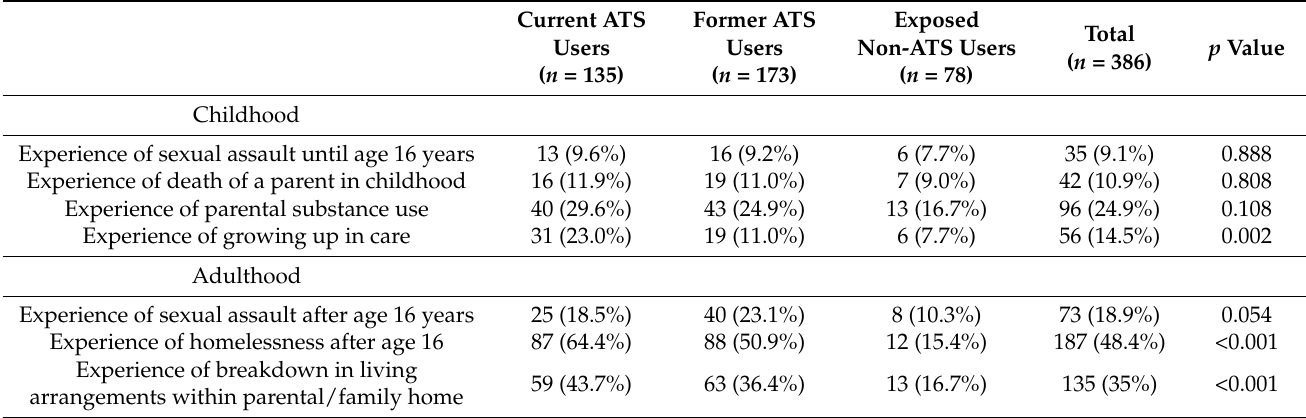
Table 5. Prevalence of self-reported experience of adverse events in childhood and adulthood by study group 1